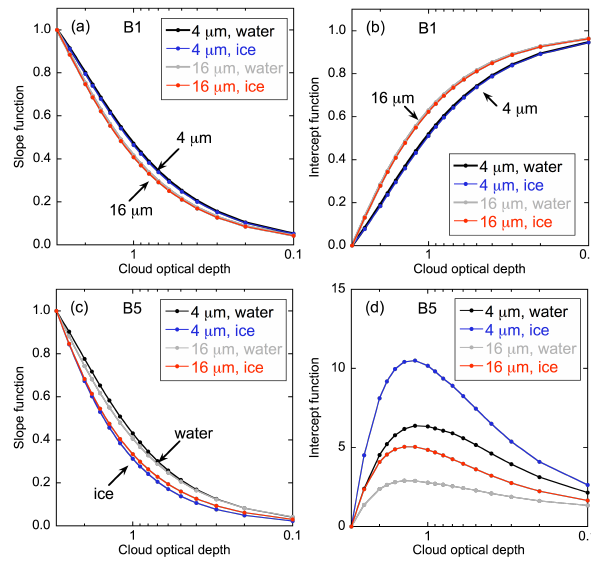
Fig. 8. Same as Fig. 5, but for liquid- and ice-phase clouds with Figure. 8. Same as Fig. 5, but for liquid- and ice-phase clouds with effective sizes of 4 and 16 4 effective sizes of 4 and µm. 5